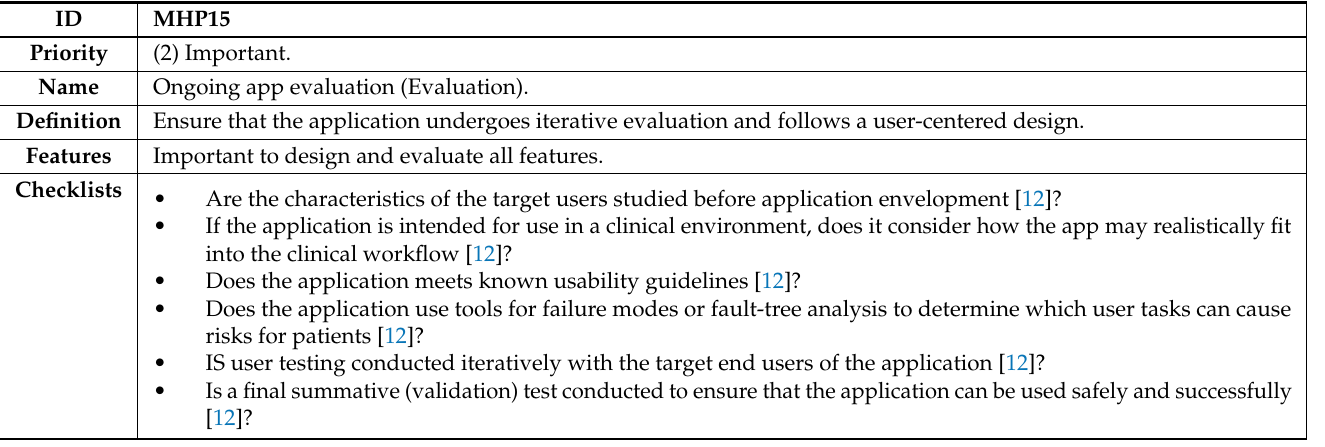
Table A15. Descriptive details of the fifteenth guideline.